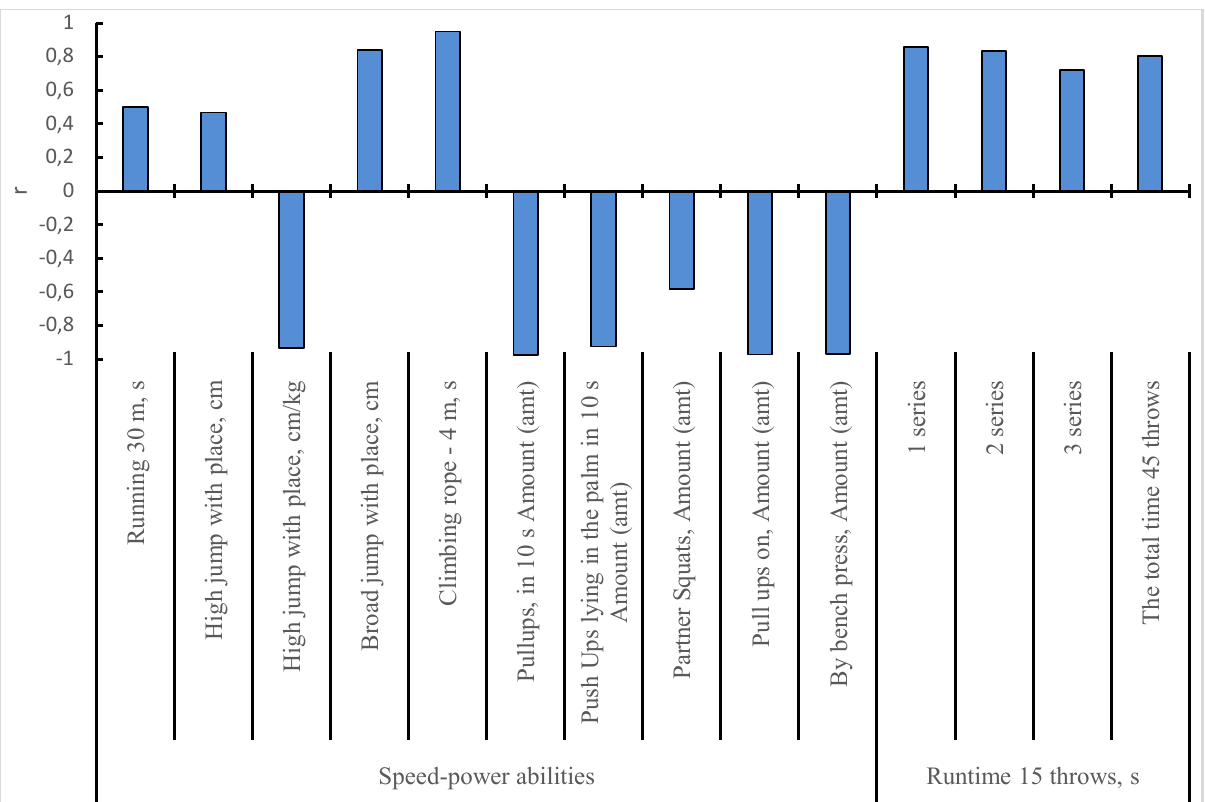
Fig.2. Interconnections of speed-power endurance’s indicators with weight categories of highly qualified wrestlers